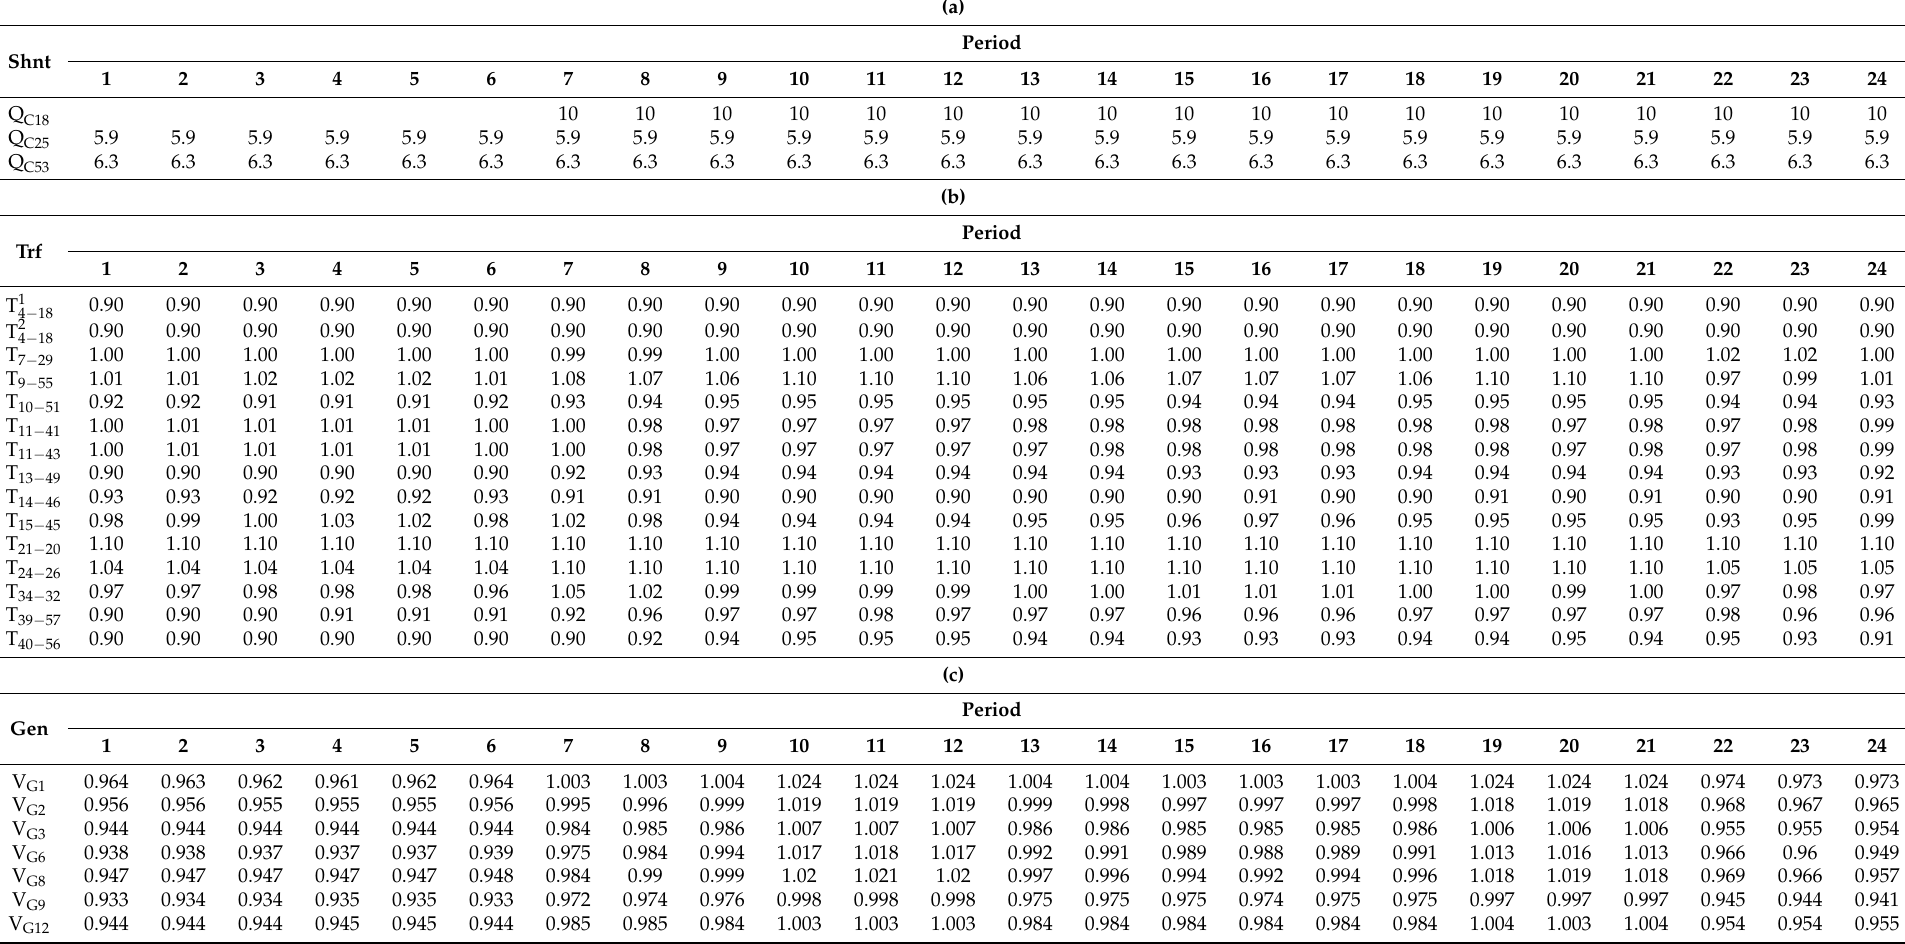
Table A1. Schedule of control variables of the MP-ORPD for the IEEE 57-bus